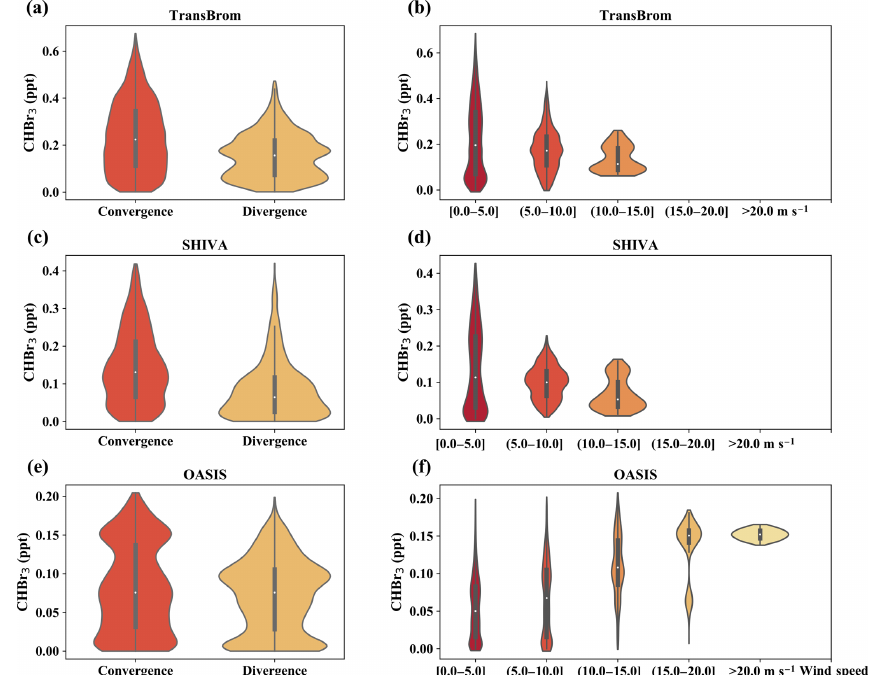
Figure 5. Violin plots of regional distributions of simulated background CHBr 3 mixing ratio by convergence and divergence (a, c, e) and by wind speed (b, d, f) at 1km altitude averaged over TransBrom (a, b) , SHIVA (c, d) , and OASIS (e, f) . The violin is a corresponding density plot with a boxplot inside. The white dots represent the medians. The thick black bars in the center represent the interquartile ranges. The thin black lines represent the rest of the distributions, except for the